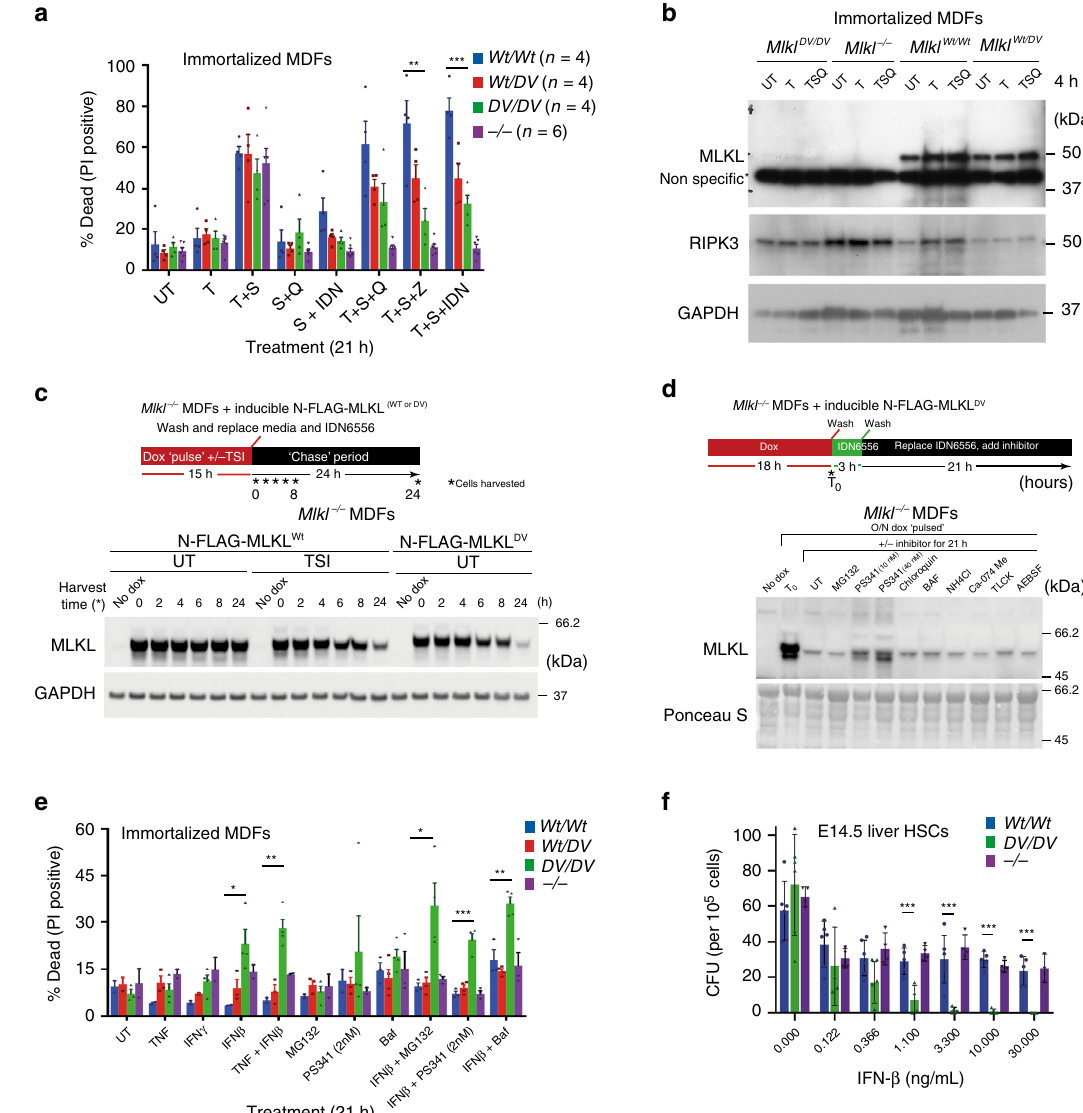
Fig. 4 MLKL D139V undergoes constitutive post-translation turn-over. MDFs were isolated from Mlkl Wt/Wt , Mlkl Wt/D139V , Mlk D139V/D139V or Mlkl − / − pups , immortalized and stimulated as indicated for 21 h for quanti fi cation of PI-positive cells using fl ow cytometry ( n = 4, 4, 4, and 6) ( a ), or for 4 h for western blot analysis ( b ). Mlkl − / − MDFs were stably transduced with doxycycline-inducible FLAG-MLKL WT and FLAG-MLKL D139V constructs to examine MLKL protein stability after doxycycline withdrawal ( c ) and in the presence of indicated compounds (FLAG-MLKL D139V ) ( d ). e Immortalized MDFs from ( a ) were stimulated as indicated for 21 h for quanti fi cation of PI-positive cells using fl ow cytometry ( n = 2 – 3, 3 – 4, 4, 2 – 3). f E14.5 fetal liver cells from Mlkl Wt/Wt , Mlk D139V/D139V or Mlkl − / − embryos were plated in the presence of indicated dose of IFN- β and colonies enumerated after 7 days ( n = 4 – 6). ( a , e and f ) represent mean ± SEM (A,E) or ±SD ( f ). b – e Representative images of at least three similar experiments. * p ≤ 0.05, ** p ≤ 0.01, *** p ≤ 0.005 calculated using an unpaired, two-tailed t